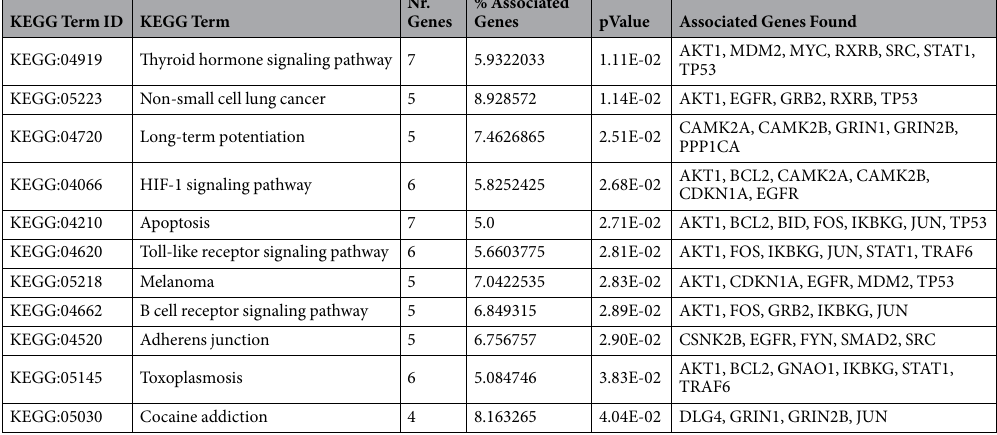
Table 2. KEGG category enrichment analysis of the neuronal differentiation annotated network obtained using ClueGo plugin of the Cytoscape software. Enriched categories identified are those with p-value <